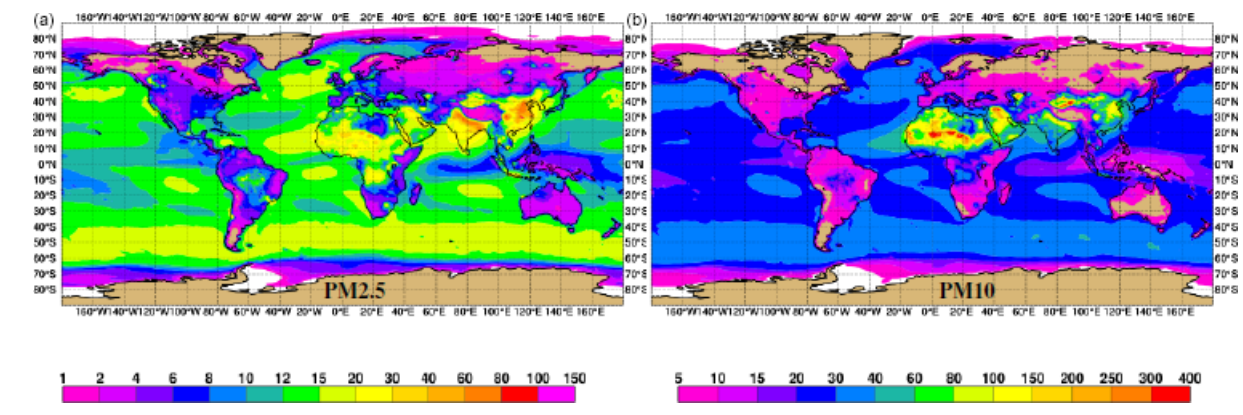
Figure 3. Global mean 2017 PM 2 . 5 (a) and PM 10 (b) (in µgm − 3 ) simulated by the CY47R1_NEWDEP experiment in cycling forecast mode. Please note the different scales for PM 2 . 5 and PM 10